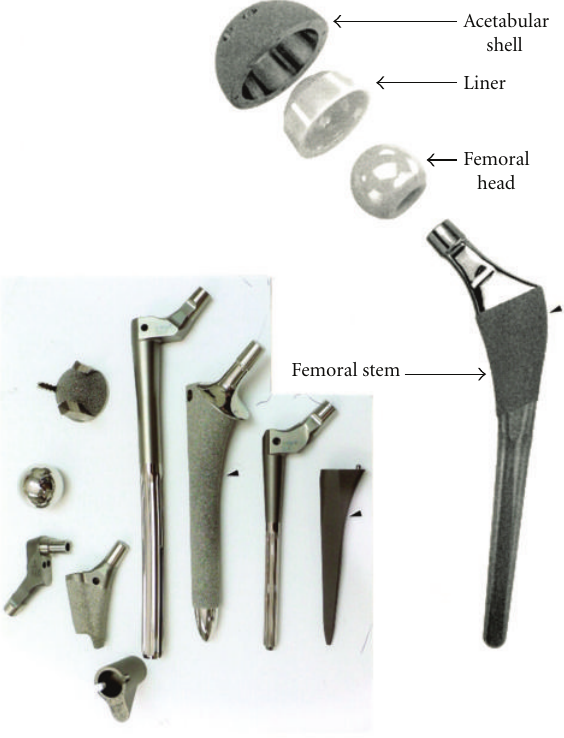
Figure 11: Total hip replacement components and examples of commercial hip stem implants. Small arrows illustrate porous coating areas using sinter technologies. Commercial examples (lower left) courtesy of DiSanto, Inc.